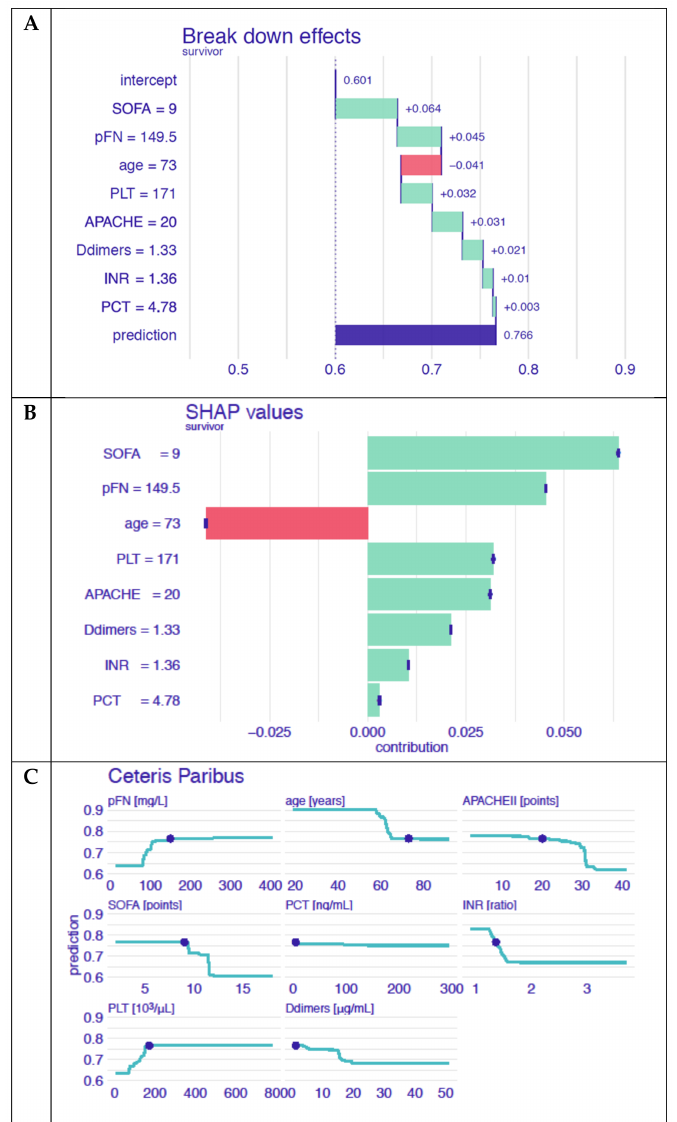
Figure 5. The survival prediction model for a selected patient. ( A ) The impact of the values of particular features on the survival prediction based on the Break Down method: an example based on data collected on admission to the ICU. ( B ) The impact of the values of particular features on the survival prediction based on SHAP values: an example based on data collected on admission to the ICU ( C ). The calculation of survival when one feature changed: an example based on data collected on admission to the